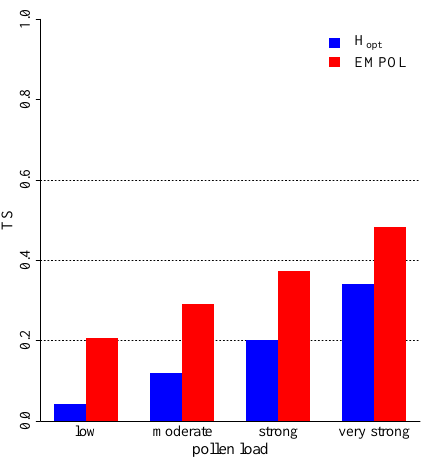
Fig. 5. False Alarm Ratio, based on classes defined by an upper and lower limit.